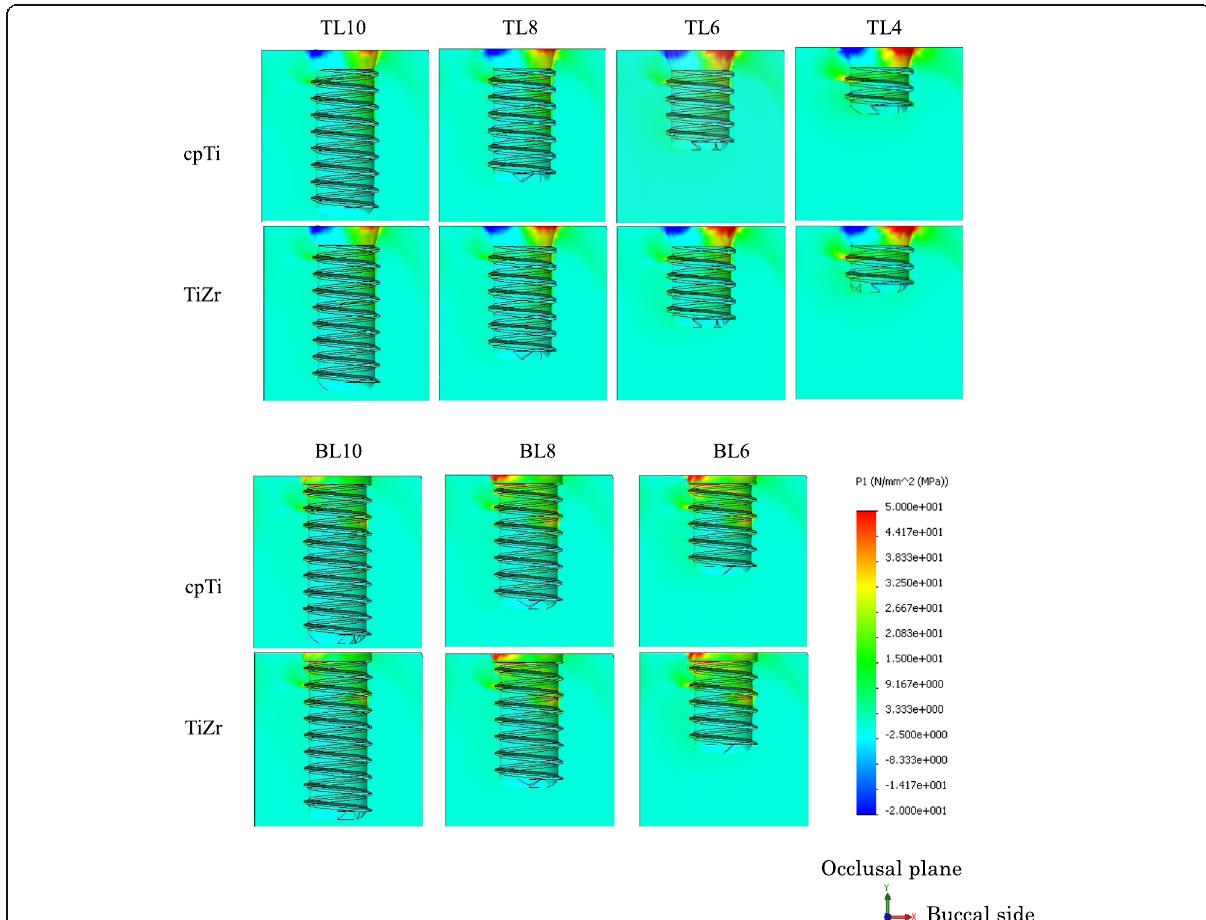
Fig. 4 Distribution of the maximum principle stress in the surrounding bone (right: buccal side, left: lingual